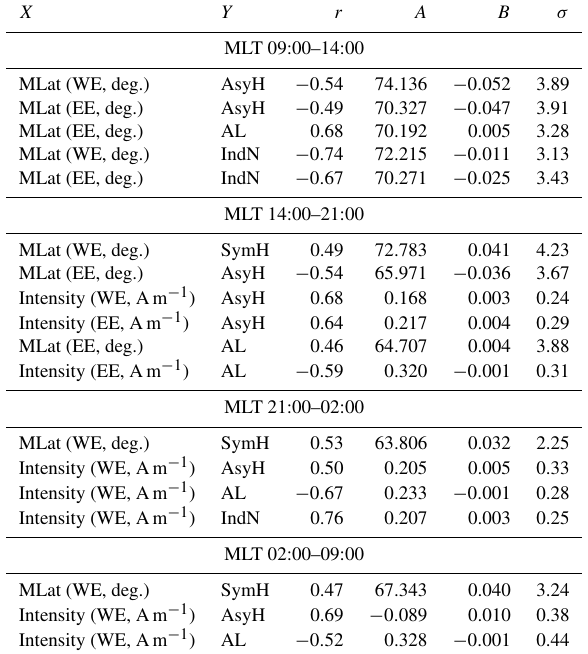
Table 3. The dependent ( X ) and the independent variable ( Y ), their correlation coefficients ( r ), the coefficients A and B of the regres- sion equations X = A + B × Y , and their dispersions σ , listed for four different MLT